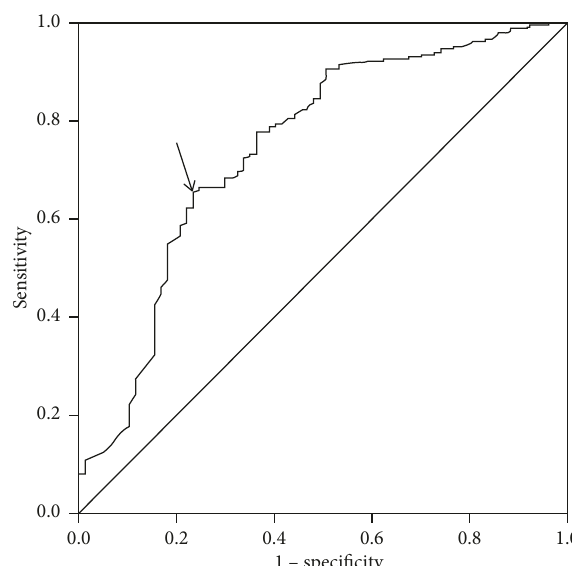
Figure 2: Receiver-operating characteristics (ROC) curve for esti- mating the TKC. A linear estimation equation was used to determine the best threshold for distinguishing between keratoconus and normal eyes with the ROC curve. The area under the ROC curve is 0.74 (arrow). The maximum Youden index is marked with an arrow on the graph. The Youden index is (sensitivity+specificity − 1)